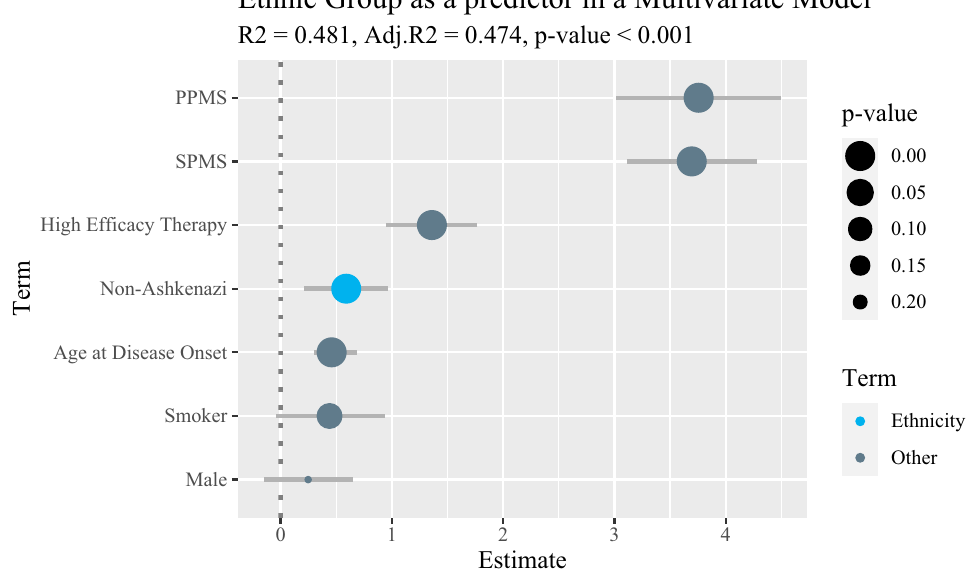
Figure 1. Ethnic group as a predictor in a multivariate model, this figure plots the estimates of the terms included in a multivariate regression model predicting MSSS (Multiple Sclerosis Severity Score). The terms plotted are organized by estimate value and are expressed in circles sized reversely to their p value, as depicted in the legend titles "p-value". Ethnicity is marked in the plot by a different color (blue) for emphasis. Ethnicity is shown to be a significant predictor of MSSS with an estimate value larger than those of Smoking, Date of onset, and Male